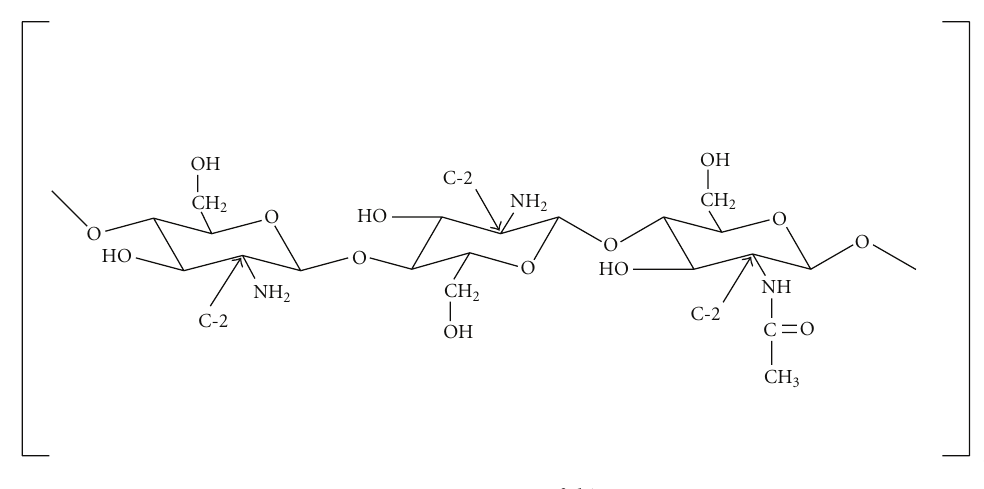
Figure 1: Structure of chitosan.